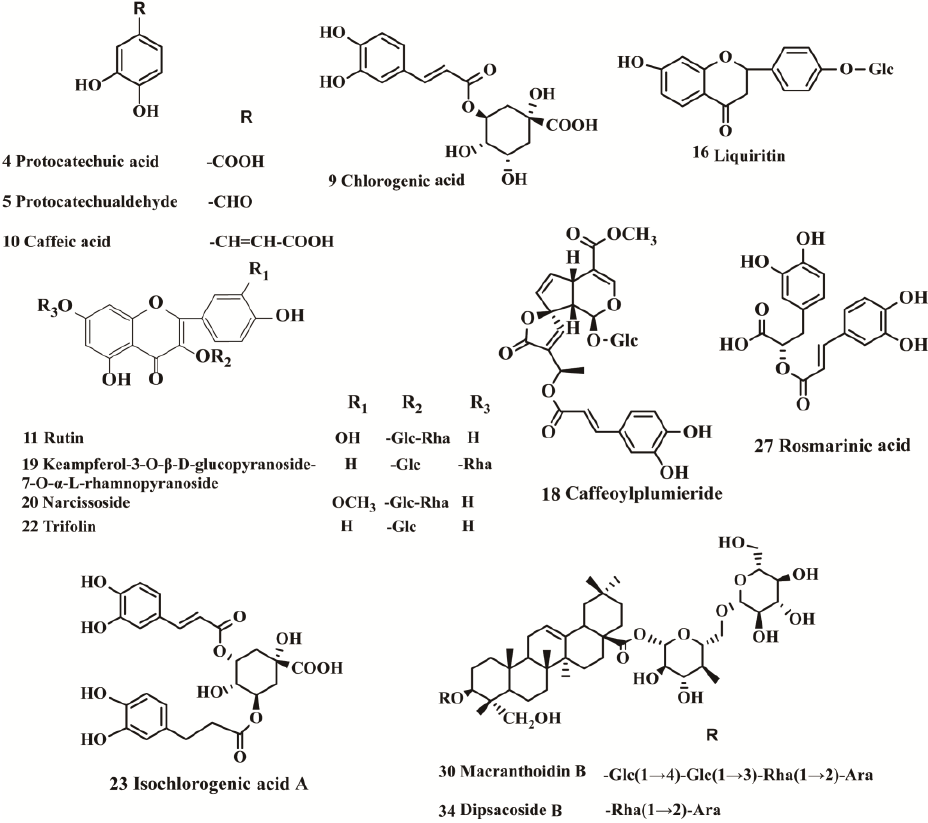
Figure 4. Chemical structures of the 14 reference substances.